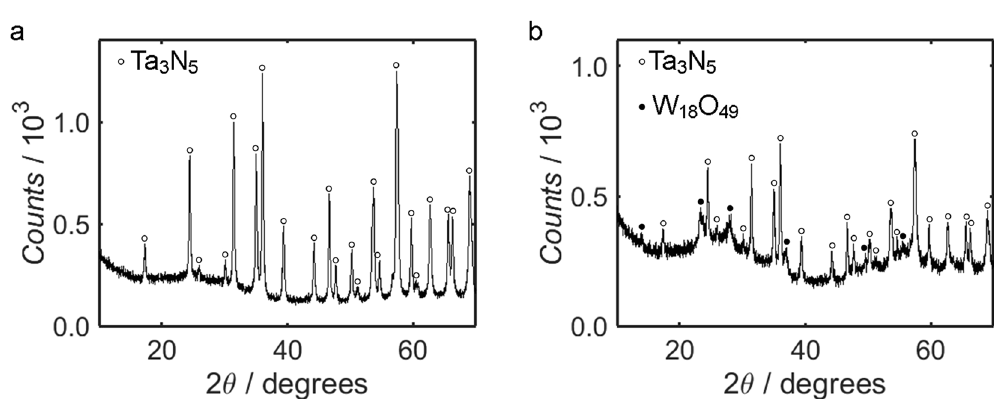
Figure 2. XRD diffractograms of the Ta 3 N 5 precursor ( a ) and Ta 3 N 5 /W 18 O 49 nanocomposite ( b ). The peaks corresponding to orthorhombic Ta 3 N 5 and monoclinic W 18 O 49 have been indexed using JCPDS card numbers 79–1533 and 71–2450,